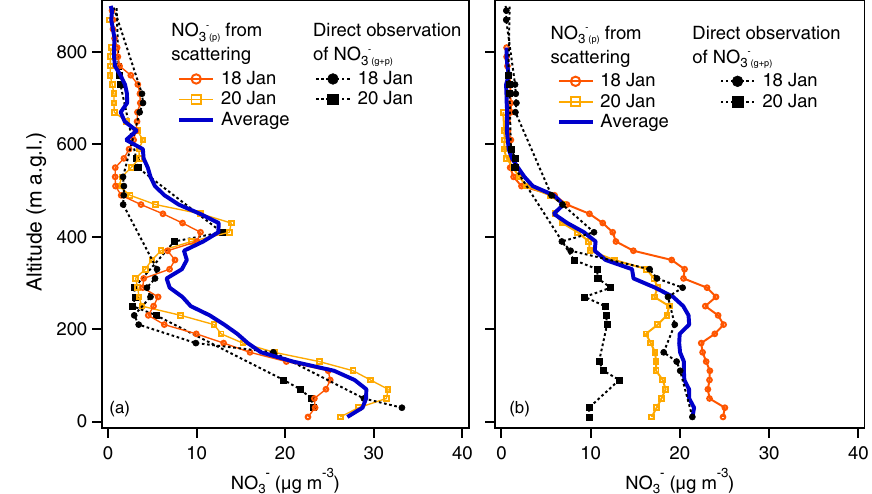
Figure 2. Vertical profiles for 2 individual flight days of particulate nitrate concentrations estimated from in situ total particle scattering measurements (open markers) and total nitrate (gas + particle) concentrations measured by the TD-LIF (solid black markers) for (a) the morning ( ∼ 09:30LT) and (b) the afternoon ( ∼ 14:30LT). The solid blue lines indicate the average NO − days of Episode 1 (18, 20, 21 and 22 January).